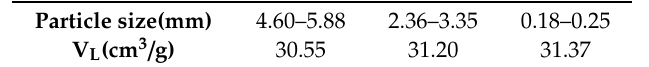
Table 4. Langmuir parameters for YQ-WK samples with di ff erent particle